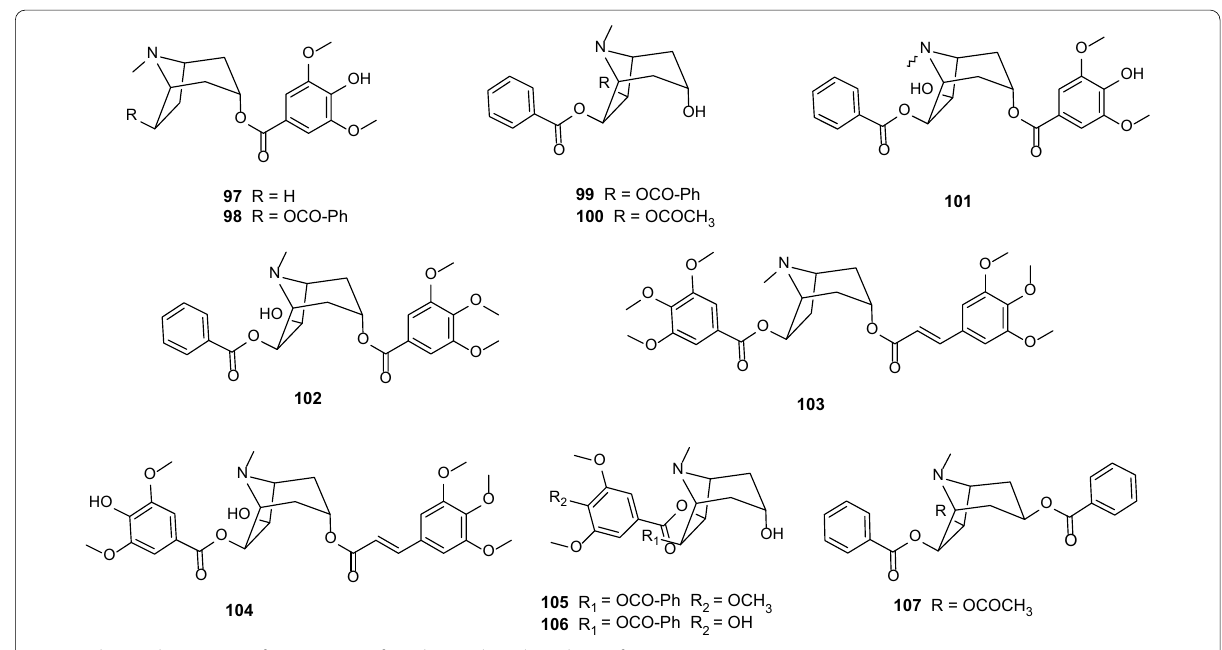
Fig. 6 Chemical structures of TAs ( 97–107 ) found in Erythroxylum plants after 2010